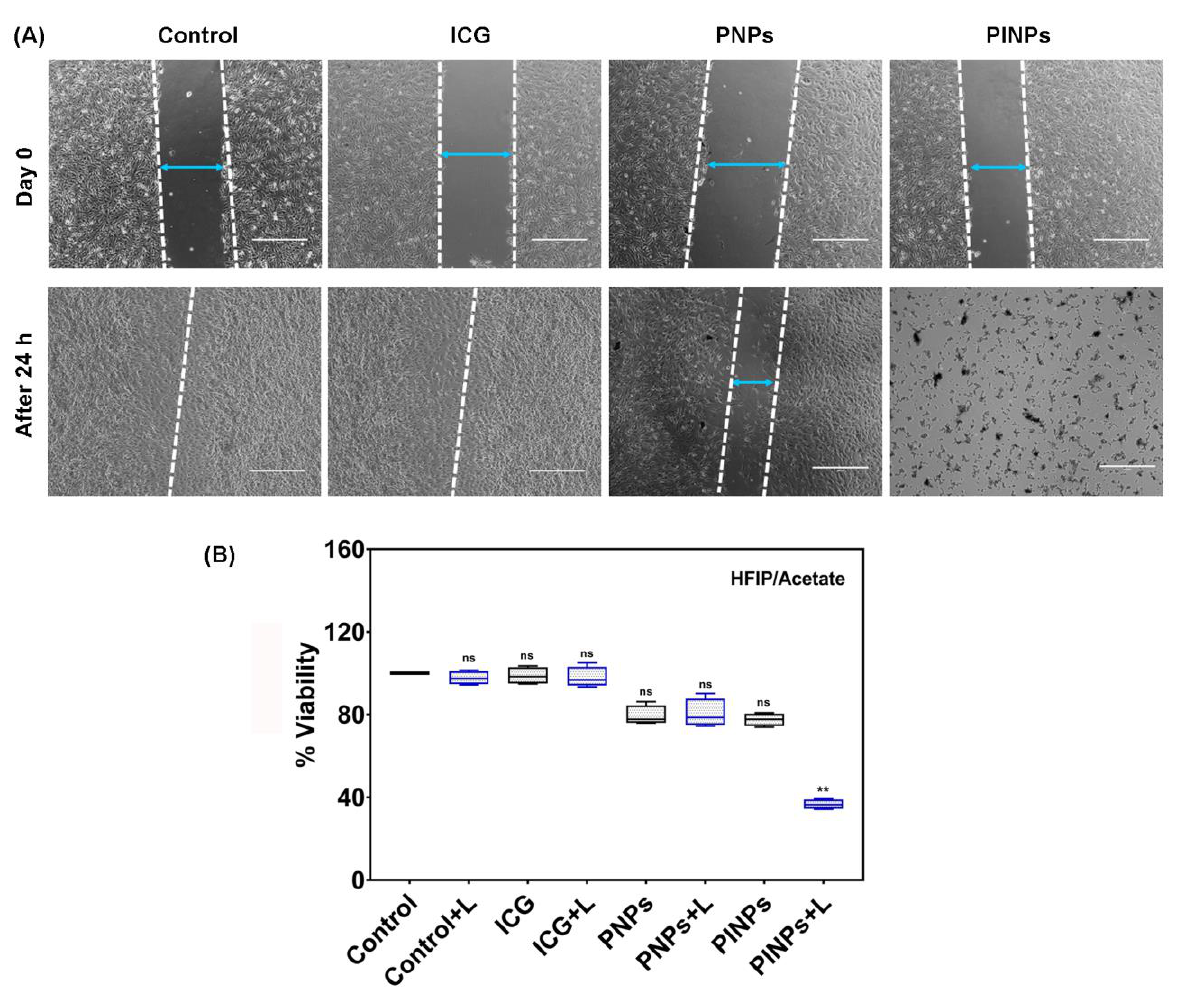
Figure 6. ( A ) Scratch assay showing migration of C6 cells after being incubated with PINPs, ICG, PNPs, and control untreated cells after laser irradiation. The dotted lines mark the areas lacking cells and blue color arrows represents the gap width. (magnification: ×400). ( B ) Collaborative chemo-PTT/PDT toxicity of PINPs (5 µg/mL) in C6 cells before and after laser irradiation. Results are presented as median and quartiles (min. to max.) in quadruplicate. The bar inside the box represents the median. Statistical analysis was carried out using a Kruskal–Wallis test followed by a Dunn’s post hoc test. Asterisk (*) refers to the statistically significant difference between the control untreated cells vs. other groups. (** p < 0.01; ns = non-significant).